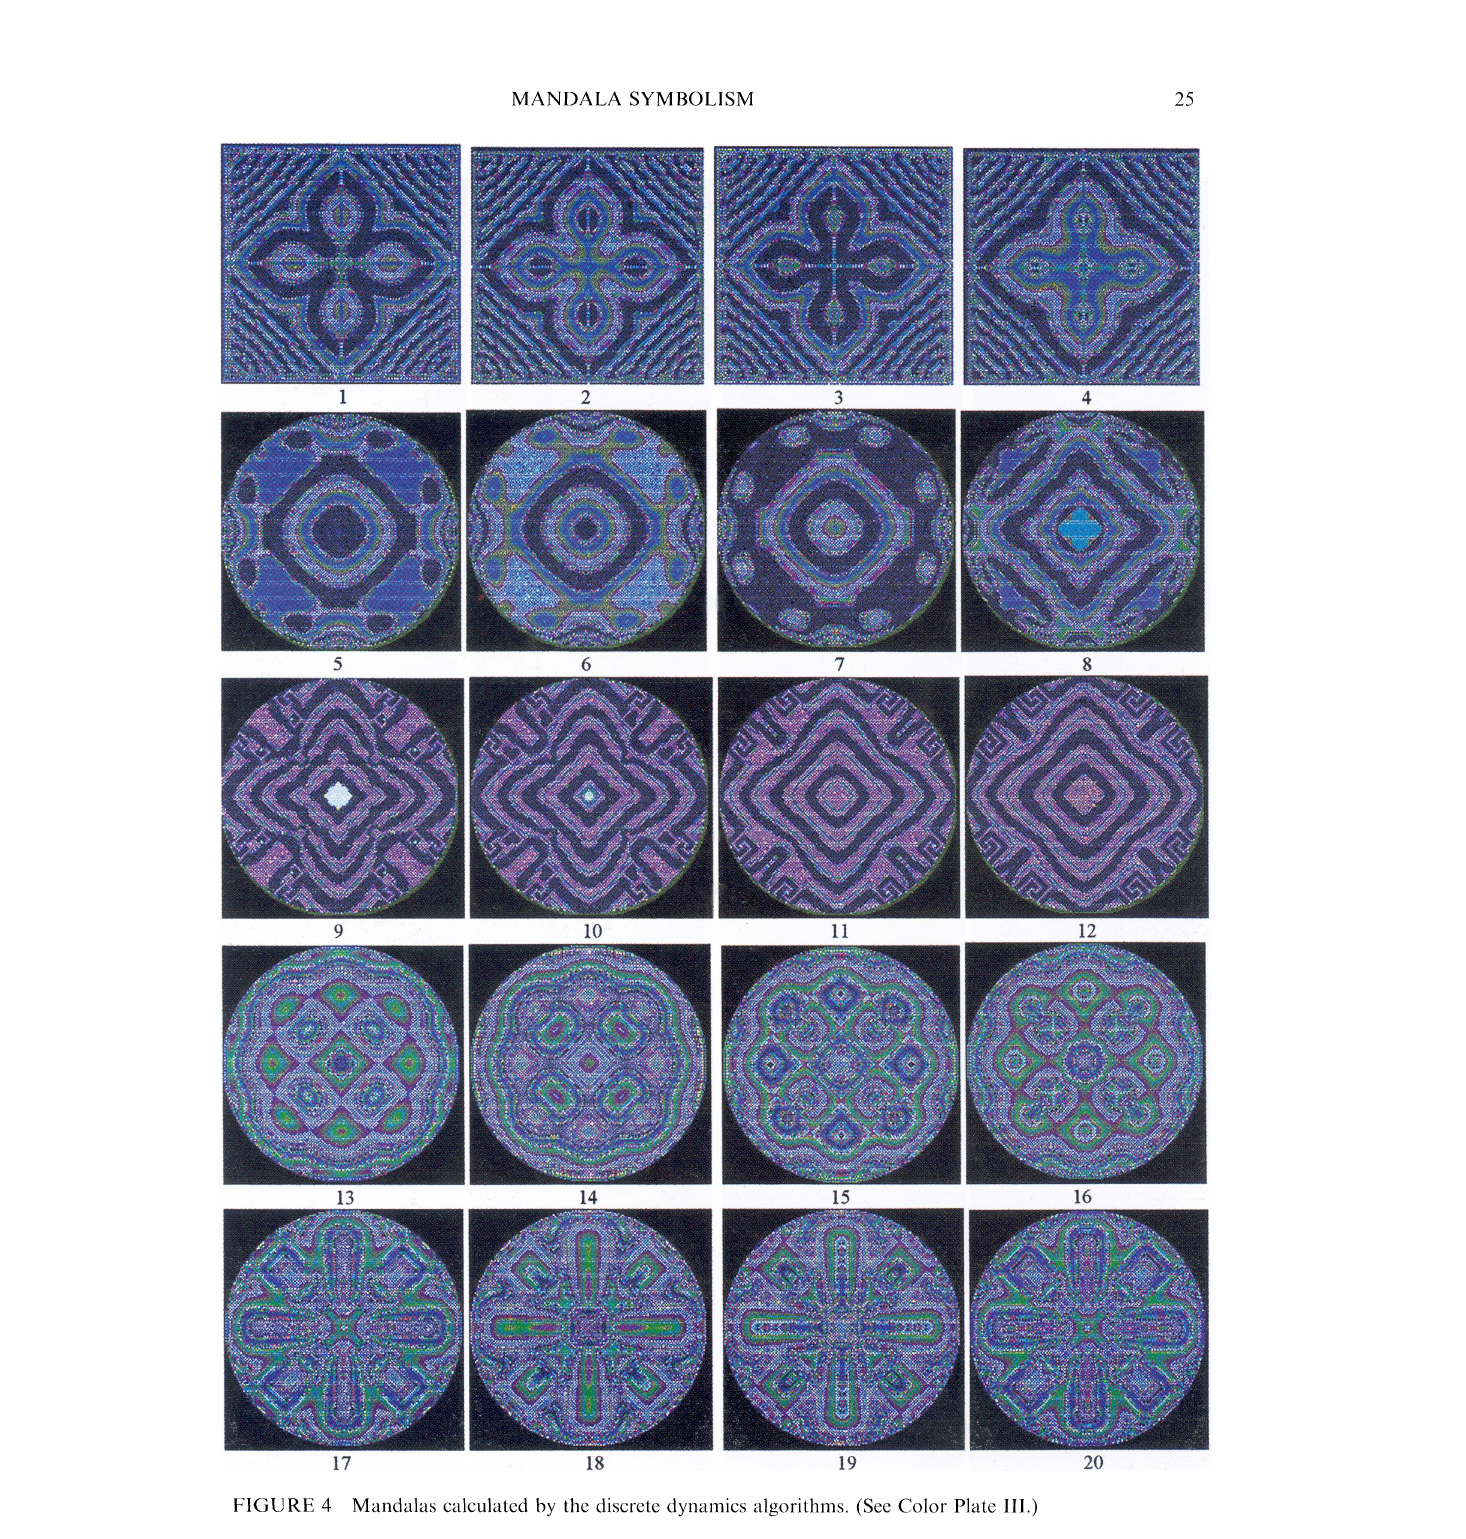
FIGURE 4 Mandalas calculated by the discrete dynamics algorithms. (See Color Plate